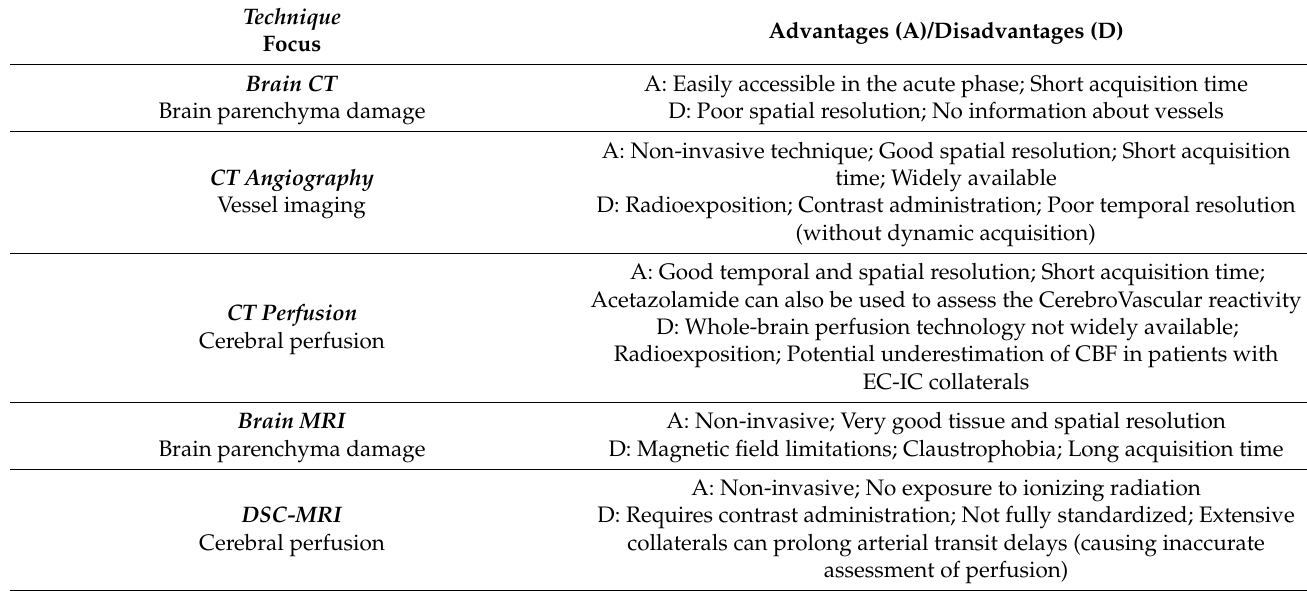
Table 3. Multimodal imaging assessment of